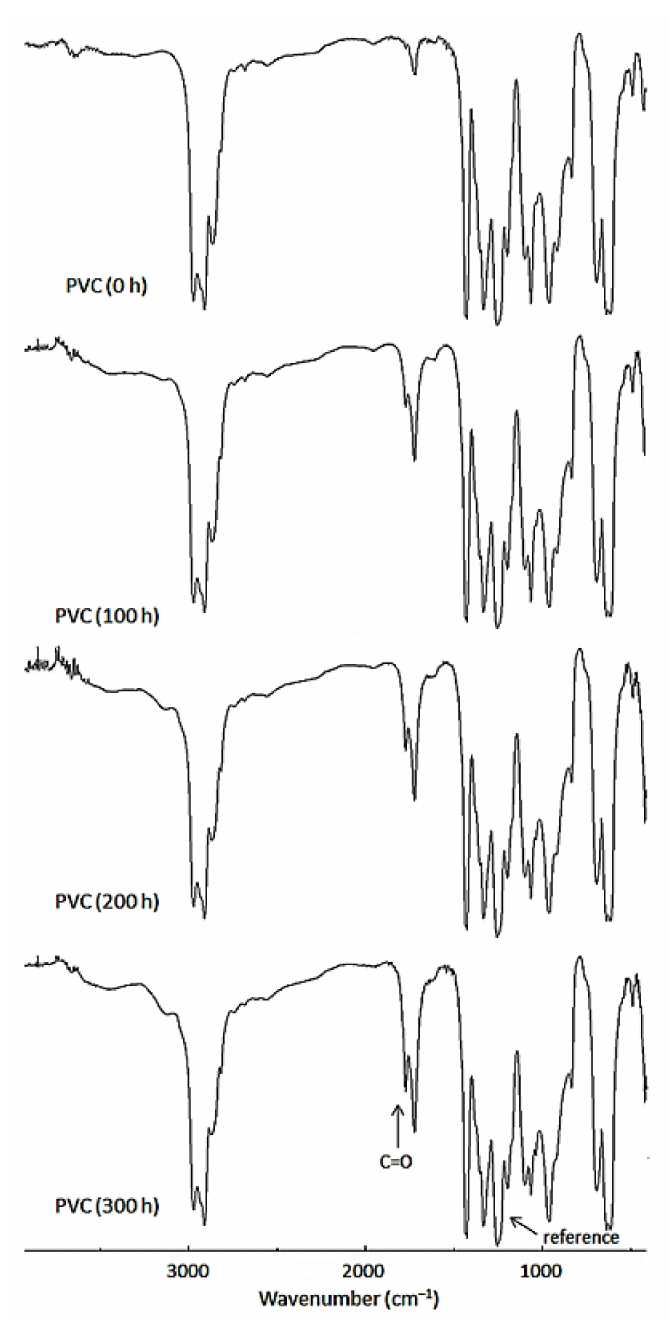
Figure 3. Changes in FTIR spectra of PVC upon